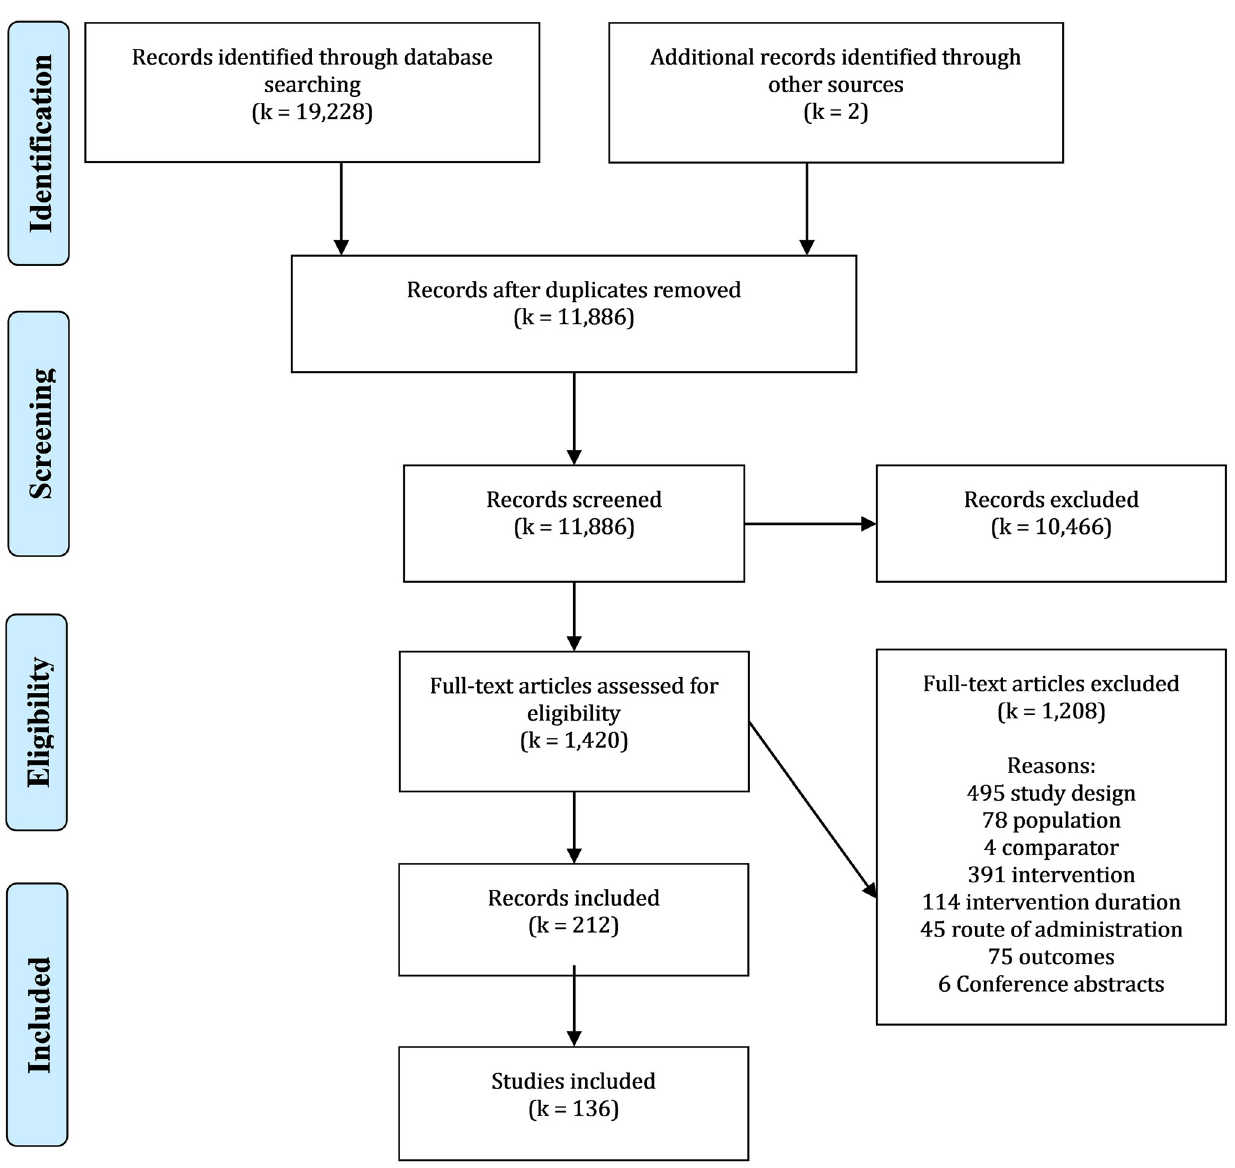
Fig 1. Study selection flowchart. � Reasons for full–text exclusion are listed in the order they were assessed.